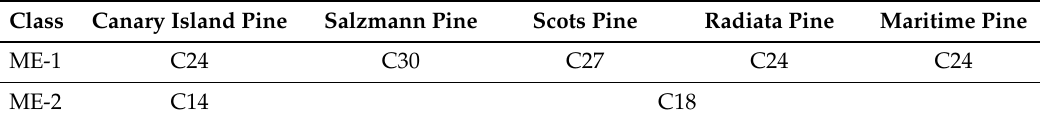
Table 7. Spanish pine strength classes in standard EN 1912